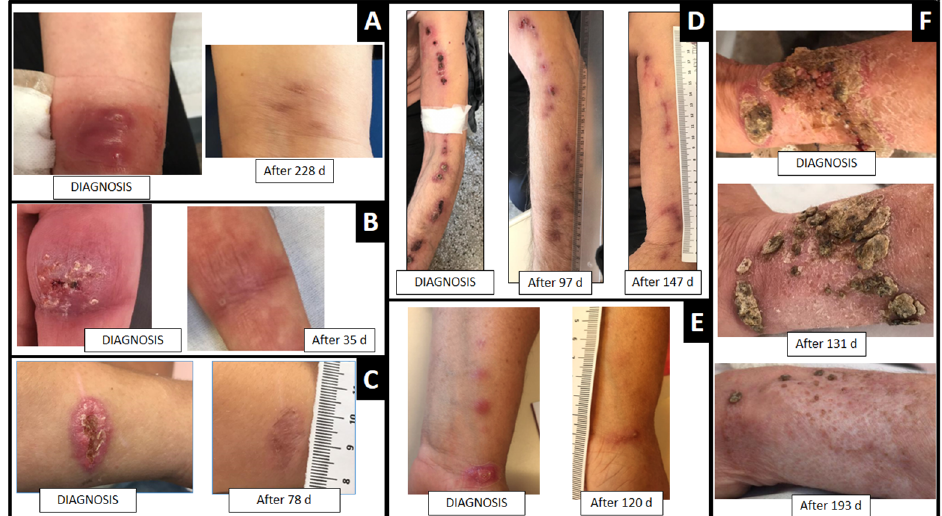
Figure 2. Clinical cure in days (d) of adult patients with cutaneous sporotrichosis from southern Brazil treated with ITZ and/or KI. ( A , B , D , E ). Lymphocutaneous form of sporotrichosis localized in the upper limb. ( C , F ). Focal cutaneous form of sporotrichosis localized to the upper limb.